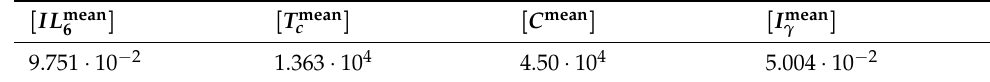
Table A1. Mean values of the variables from the data.